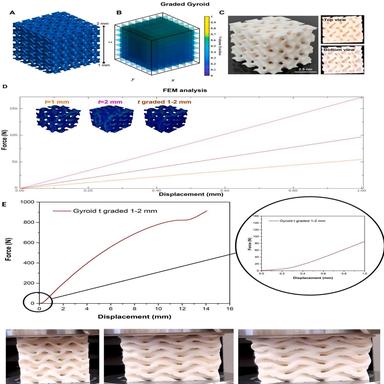
(A) Matrix representation of soft graded gyroid lattice, (B) and corresponding linear volume fraction preview. (C) Soft graded gyroid printed sample. (D) Force-displacement curve derived from FEM deformation of the soft graded gyroid lattice (in brown) under compressive loading, compared with lattices with a uniform thickness of 1 mm (in orange) and 2 mm (in magenta). (E) The experimental force-displacement curve and a magnification of the same chart from 0 to 1 mm of displacement. At the bottom is the samp